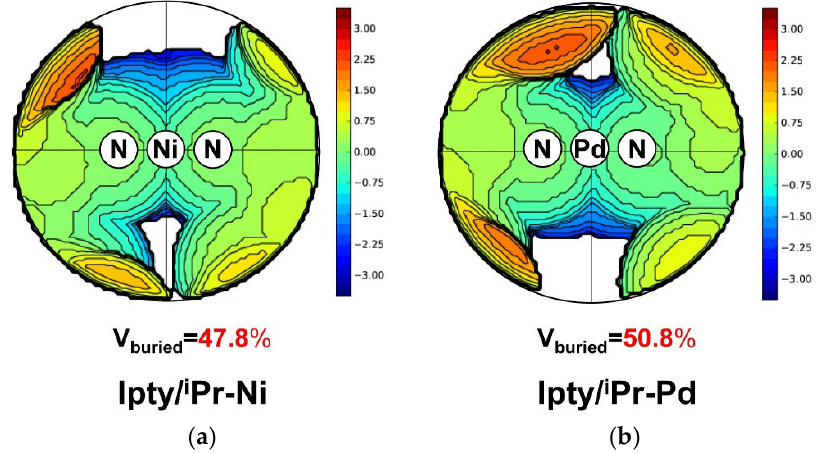
Figure 3. ( a ) Steric maps of Ipty/ i Pr-Ni ( V bur = 47.8%) based on the solid-state structure. ( b ) Steric maps of Ipty/ i Pr-Pd ( V bur = 50.8%) based on the solid-state structure.